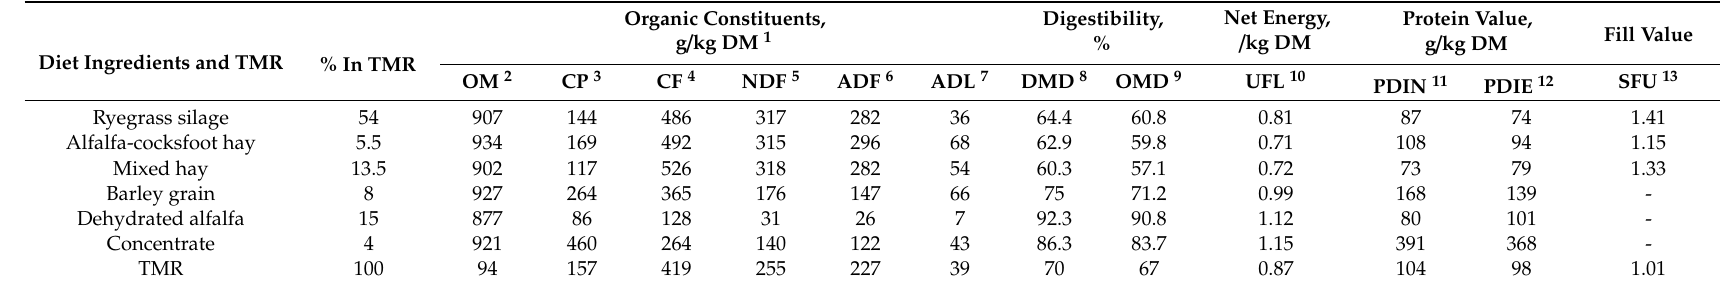
Table 1. Nutritive value of ingredients and total mixed ration